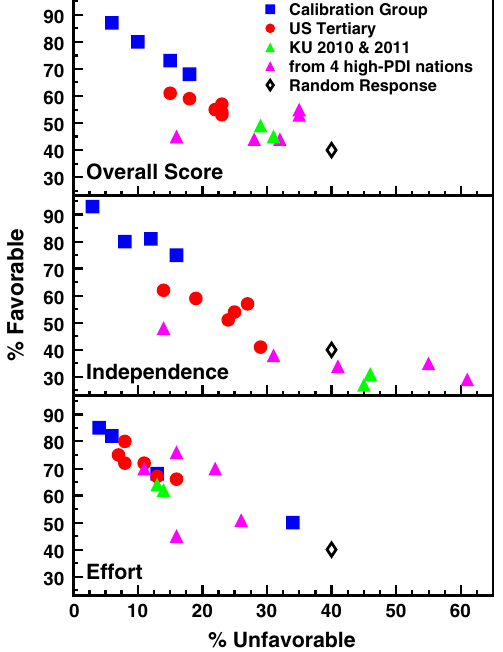
FIG. 2. The favorable-unfavorable Dalitz-style plot for prein- struction MPEX survey data comparing the Calibration Group (blue squares) and U.S. Tertiary student groups (red circles) from the original MPEX study [44] to KU students (green triangle), and students from data sets in other high-PDI nations (India, Turkey, Thailand, and Philippines)[45]. KU student data include that for the year of (2011) and the year prior to (2010) the CWP reform. The MPEX overall score (top) is compared to the question subsets for the independence (middle) and effort (bottom) clusters. The average for random responses (black diamond) is shown for benchmarking